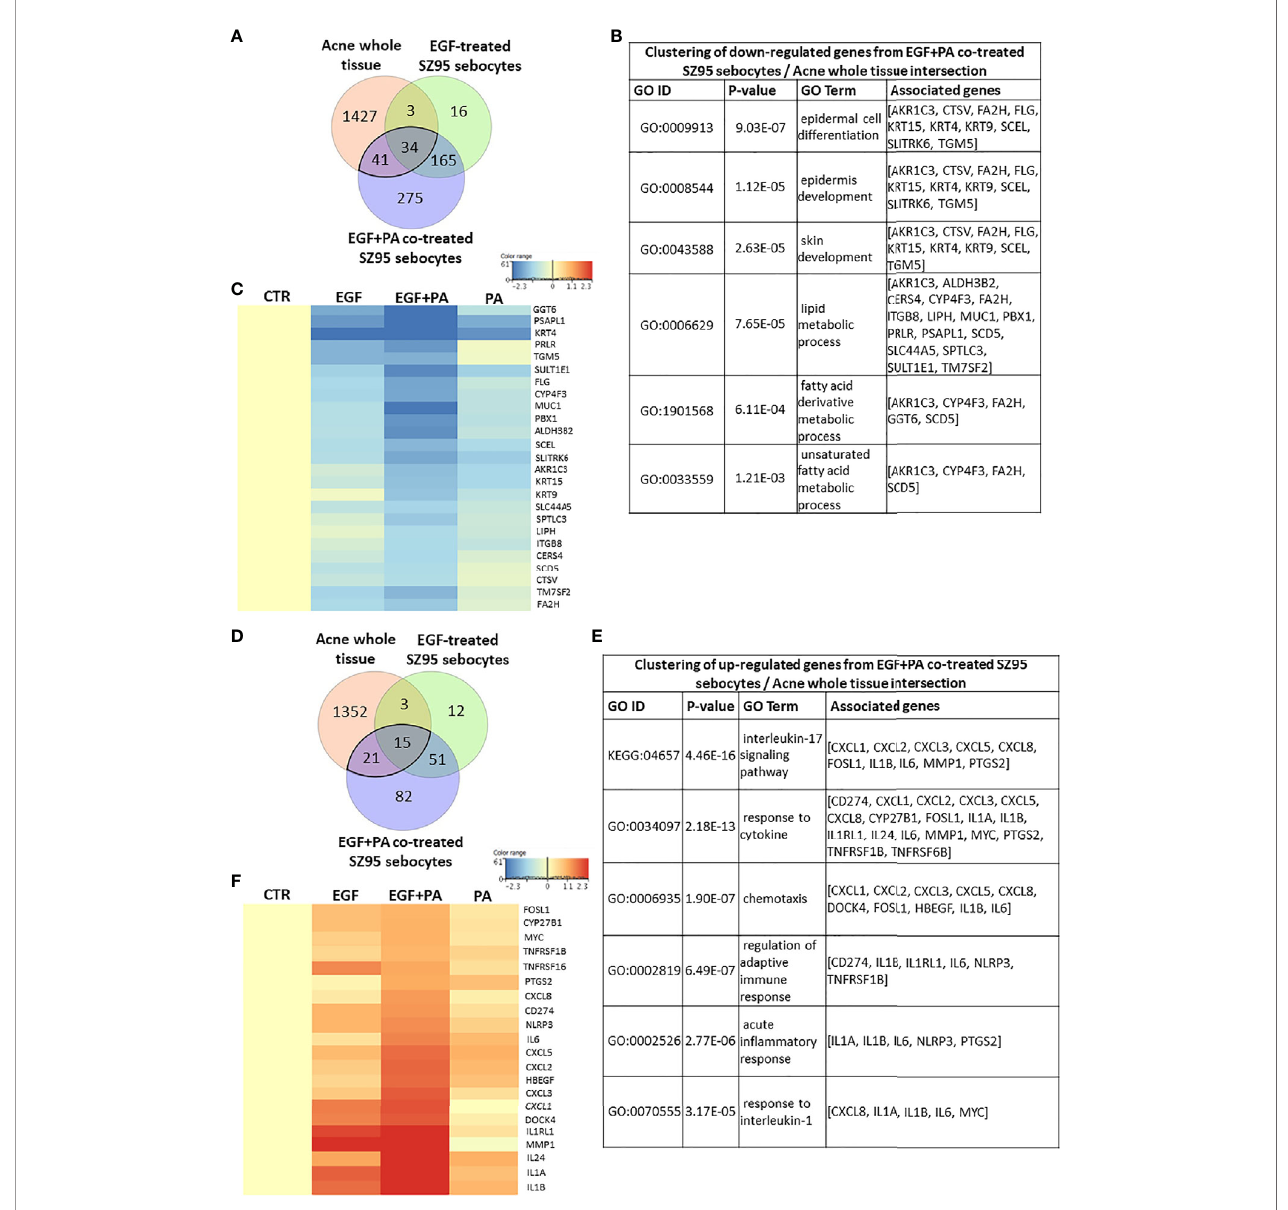
FIGURE 7 | Meta-analysis using gene expression pro fi les from acne samples, EGF-treated and EGF+PA- co-treated SZ95 sebocytes. (A) Venn diagram visualizing the number of transcripts that were signi fi cantly down-regulated in acne whole tissue samples from the available gene expression pro fi les of Kelhala HL et al. (NCBI GEO accession number: GSE5379) (56) and in EGF and EGF+PA co-treated SZ95 sebocytes. (B) Functional clustering of the 75 (41 + 34) transcripts that were signi fi cantly down-regulated both in the EGF+PA co-treated SZ95 sebocytes and in acne whole tissue samples (56) revealed that the most signi fi cant changes were related to genes involved in skin development and fatty acid metabolic process. (C) Heat map display of the genes which were clustered out of the 75 signi fi cantly down-regulated transcripts. Differentially expressed genes were normalized to control and results are expressed as average mean of three samples from subcultures of SZ95 sebocytes. Color intensities re fl ect the ratios of signal intensities as shown. (D) Venn diagram visualizing the number of transcripts that were signi fi cantly up- regulated in acne whole tissue samples from the available gene expression pro fi les of Kelhala et al. (56) and in EGF and EGF+PA co-treated SZ95 sebocytes. (E) Functional clustering of the 36 transcripts that were signi fi cantly up-regulated both in the EGF and EGF+PA co-treated SZ95 sebocytes and in acne whole tissue samples (56) revealed that EGF in combination with PA may contribute to the (patho)physiologically relevant IL1 and IL17 signaling in SZ95 sebocytes. (F) Fold change value based hierarchical clustering of the cluster forming genes, showing their expression levels in the PA, EGF and EGF+PA co-treated SZ95 sebocytes, that are signi fi cantly up-regulated in the EGF and EGF+PA co-treated SZ95 sebocytes when compared to untreated cells at 24 hours and in the available gene expression pro fi les of acne whole tissue samples (56). Differentially expressed genes were normalized to control and results are expressed as average mean of three samples from subcultures of SZ95 sebocytes. Color intensities re fl ect the ratios of signal intensities as shown. Note that the majority of the identi fi ed genes, showing a prominent expression in SZ95 sebocytes treated with PA in combination with EGF (such as CXCL8 , IL1A , IL1B , IL6 , NLRP3 and PTGS2 ), are pivotal in the pathogenesis of